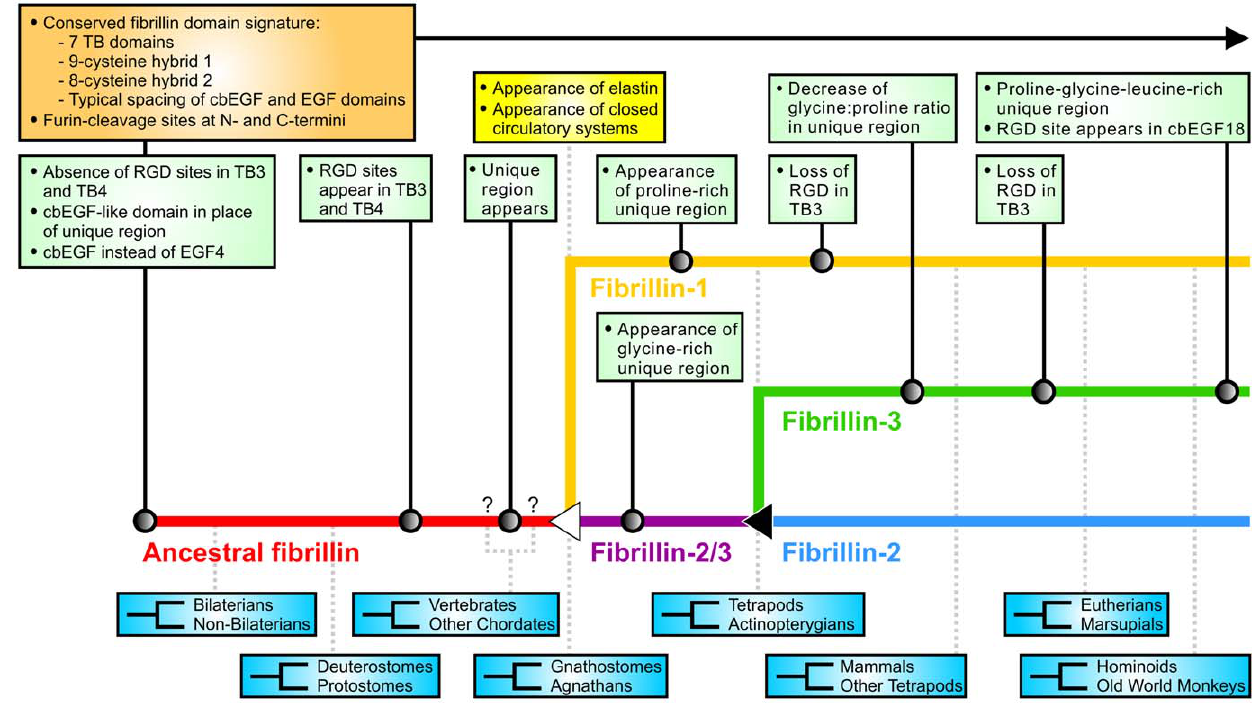
Figure 7. Hypothetical evolution of human fibrillins. An ancestral fibrillin (red) existed prior to the split of bilaterians from non-bilaterians. A gene duplication event (white triangle), presumably at the divergence of gnathostomes (jawed vertebrates) from agnathans (jawless fish), led to the genes for fibrillin-1 (orange) and the ancestral fibrillin-2 and -3 gene, coined as fibrillin-2/3 (purple), and further coincides with the appearance of elastin and the evolution of closed circulatory systems. A second duplication event (black triangle), coinciding with the evolution of tetrapods, led to the genes for fibrillin-2 (blue) and fibrillin-3 (green). The pre-eutherian fibrillin-3 gene underwent significant evolutionary changes to become present- day fibrillin-3. Taxonomic classifications and evolutionary divergence events are found in blue boxes and indicated by fork symbols, with dotted light gray connectors to the individual fibrillins. The upper classification shares a common ancestor with humans. Question marks indicate uncertainties as to whether the unique region appeared before or after the divergence of vertebrates from other chordates. Spacing between taxonomic classifications is not proportional to their evolutionary timeline. Identified conserved characteristic features and evolutionary events found in all analyzed fibrillins are highlighted in an orange-colored box with a black arrow. Evolutionary characteristics and events specific to individual fibrillins are shown in green boxes with solid connectors and circles. Important related evolutionary events are shown in a yellow box.